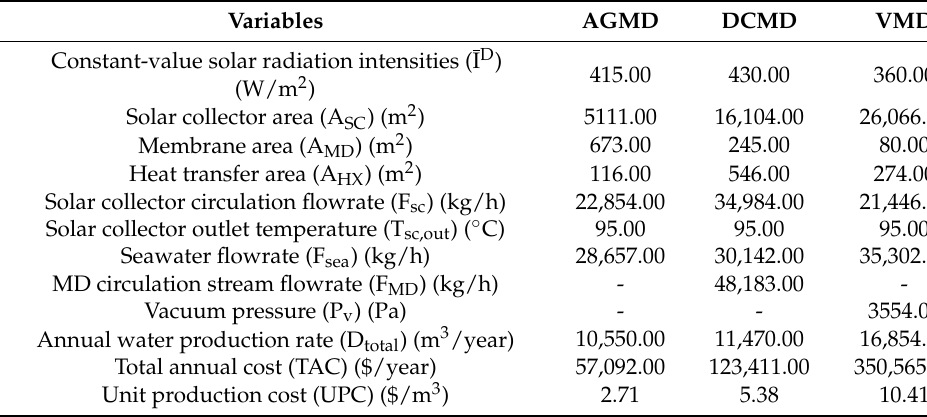
Table 5. Optimal design of the SDMD systems for